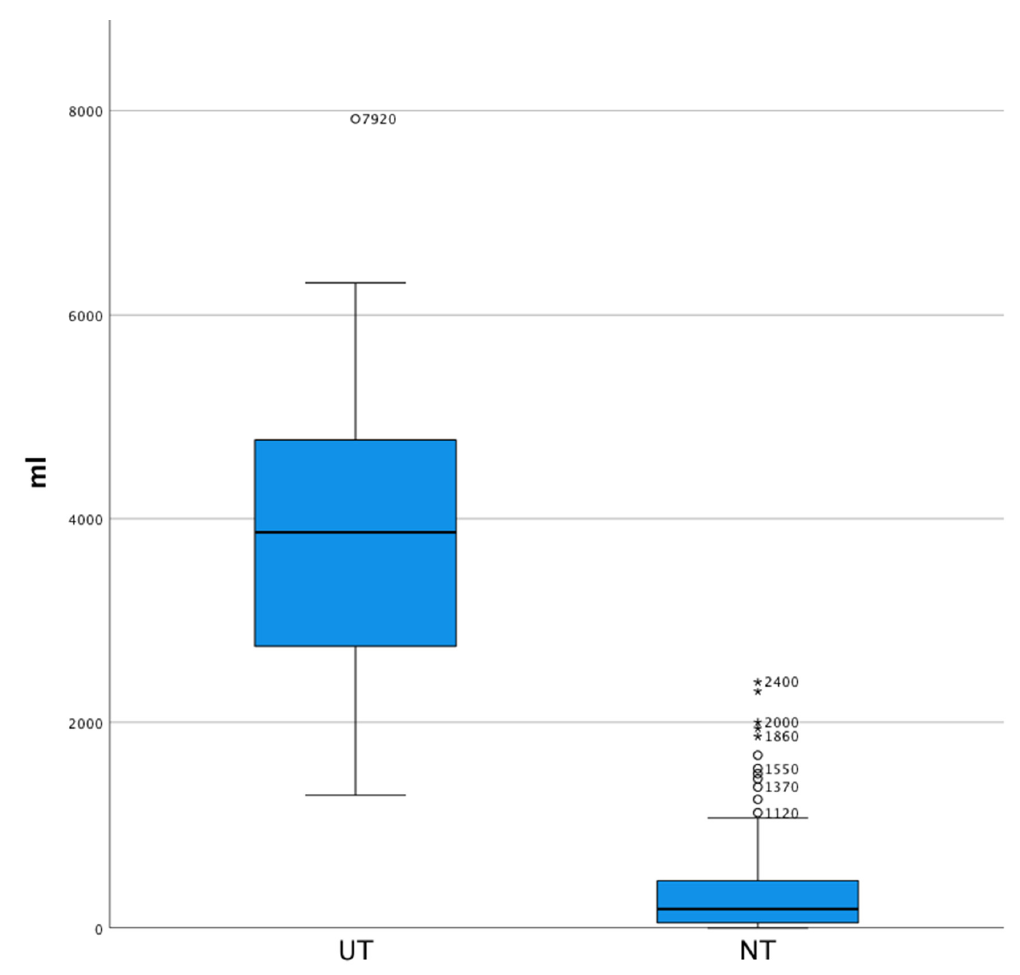
Figure 3. Boxplot diagrams comparing chest-tube output of UT and NT ( p < 0.001). o indicates datapoints within 1.5–3 IQR, * above 3 IQR.